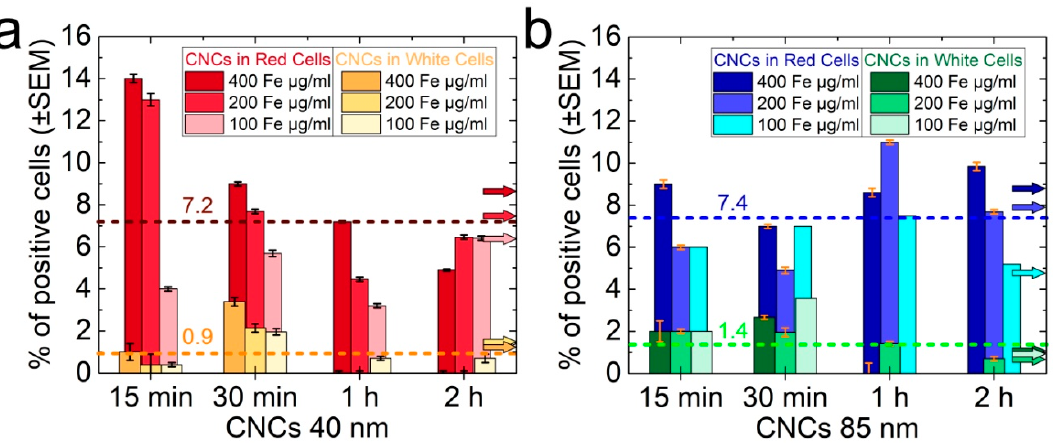
Figure 6. Uptake of CNCs [40 nm ( a ) and 85 nm ( b )] by spleen cells incubated in their presence for 15 min, 30 min, 1 h, and 2 h, as well as for three different concentrations. The percent (%) averaged values have been indicated in the diagrams by the dashed lines. The percent (%) averaged values for each nanocluster concentration are also marked by the arrows.